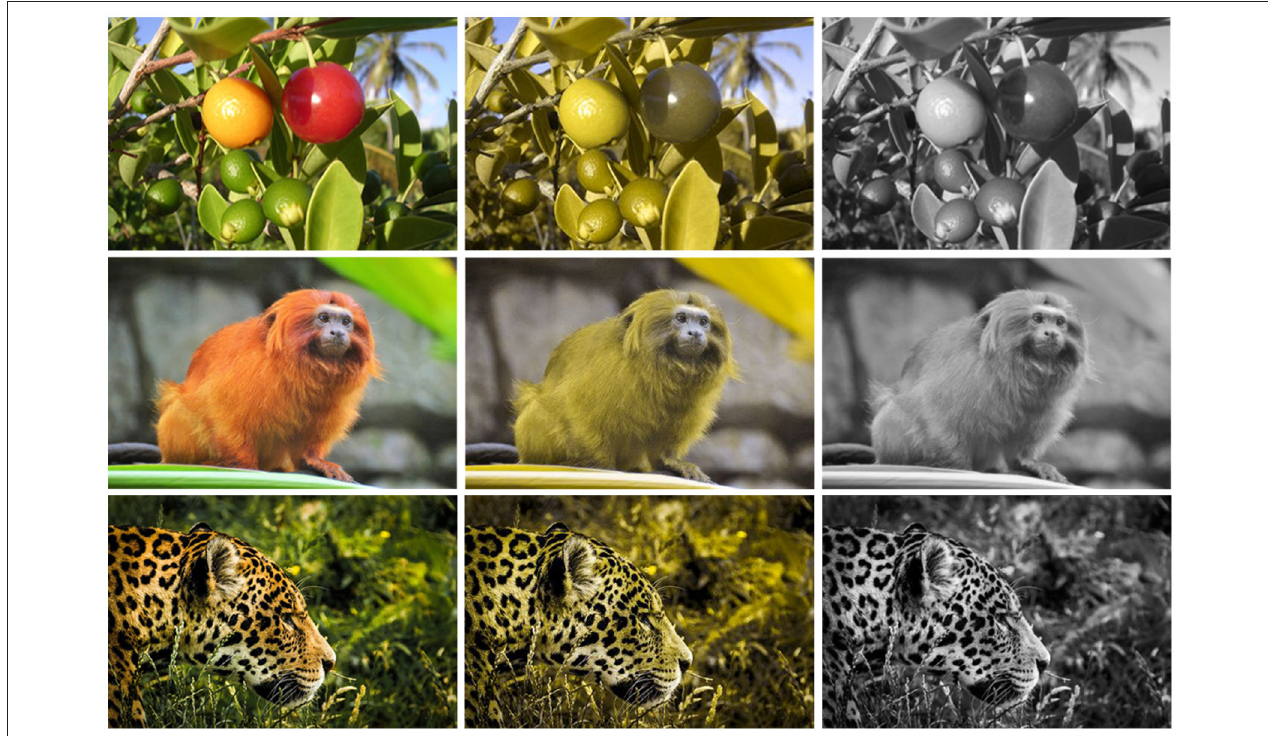
FIGURE 5 | Examples of evolutionary drives that might have influenced the evolution of primate color vision. Original pictures (left column) and simulations of dichromatic (middle column) and monochromatic (right column) vision are